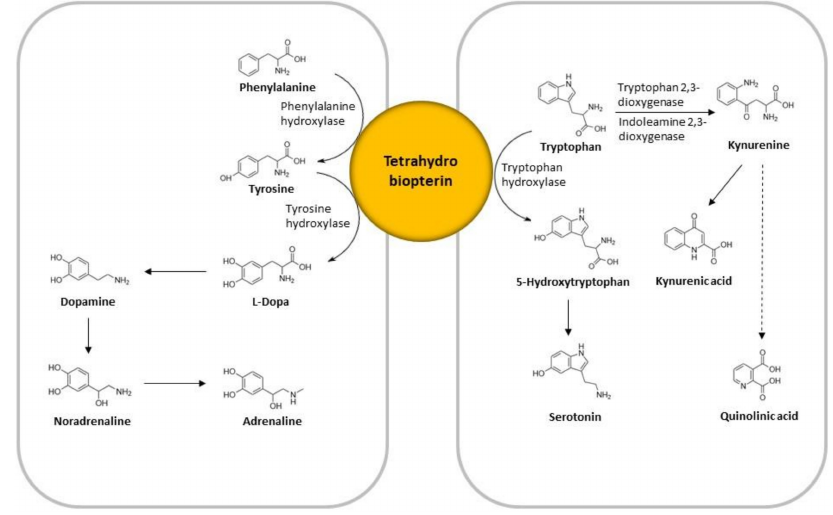
Figure 1. Graphical depiction of the amino acid neurotransmitter pathways analyzed in the current study. The central role of tetrahydrobiopterin (BH4) in both pathways is emphasized. The availability of the enzyme co-factor tetrahydrobiopterin (BH4) is essential for PHE